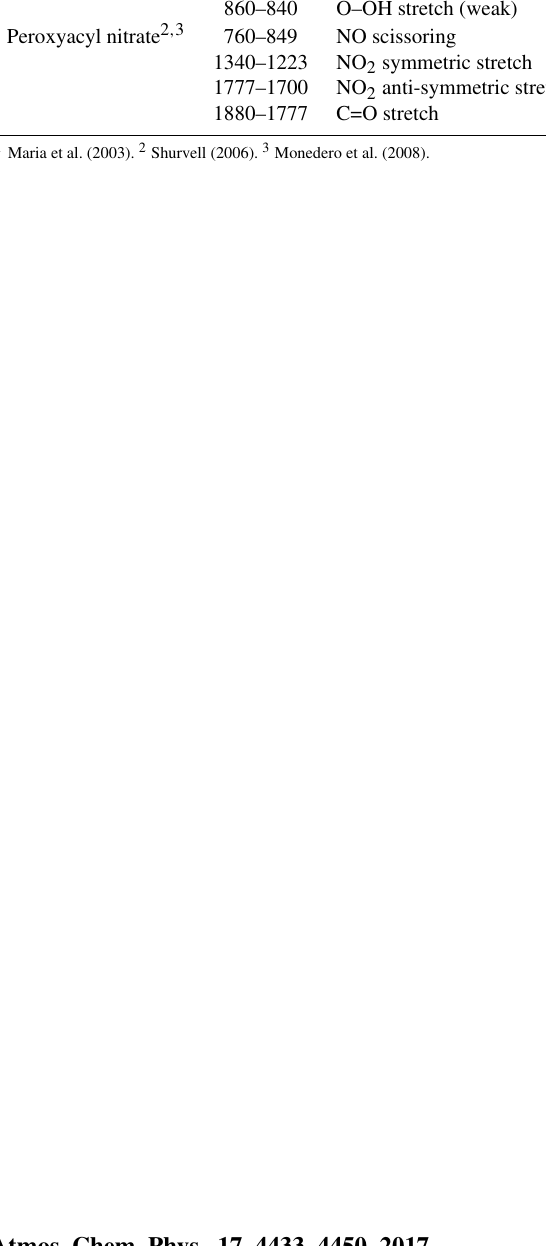
∗ ] ) a /n C ∗ . Ten col- C ] = C